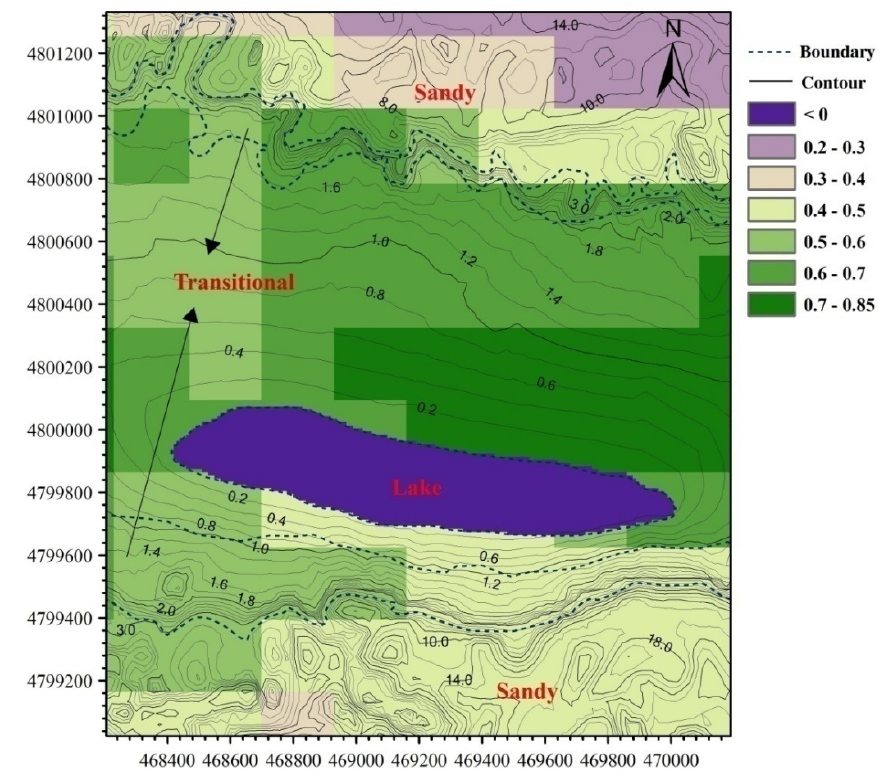
Figure 5. Map showing the contours of annual mean annual depth to water table and the annual mean maximum Normalized Difference Vegetation Index (NDVI) grids. A contour interval of 0.2 m was used for depths of less than 2 m, an interval of 1 m for depths between 3 and 8 m, and an interval of 2 m for depths greater than 8